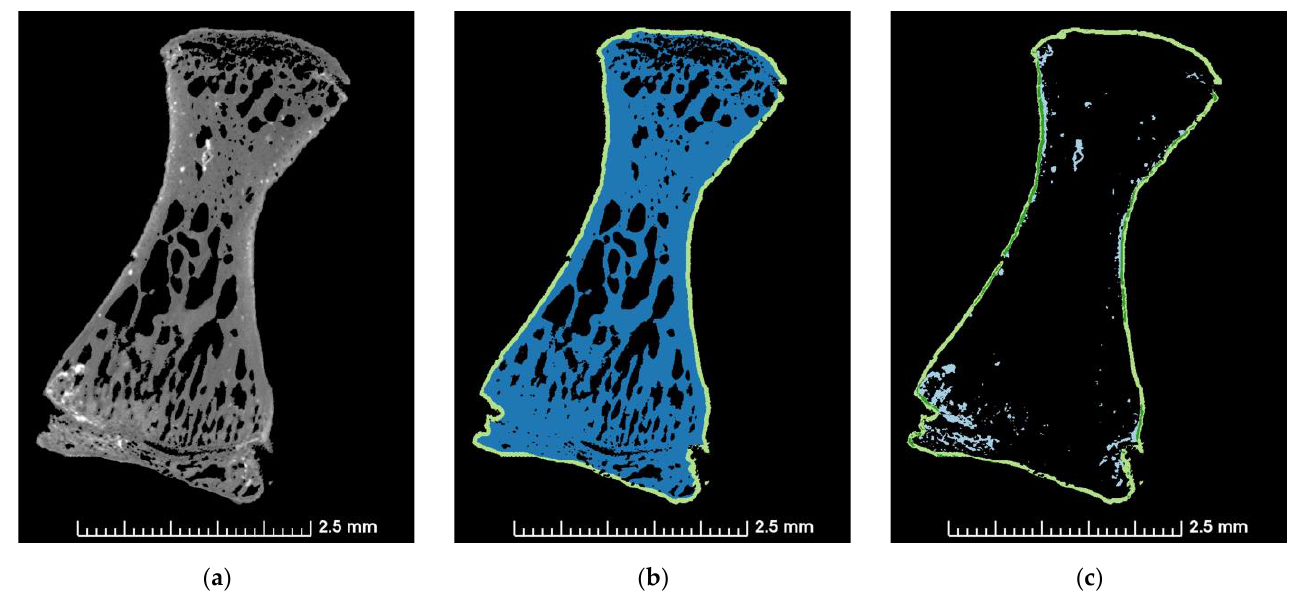
Figure 1. Stain segmentation procedure on an enhanced µCT image. ( a ) unlabeled enhanced µCT image with background removed; ( b ) bone label field (blue) less than 50 µm of the outer edge of the cortical shell (light green); ( c ) labeled BaSO 4 (light blue) used for damage volume fraction calculations and showing excluded BaSO 4 contrast (green).